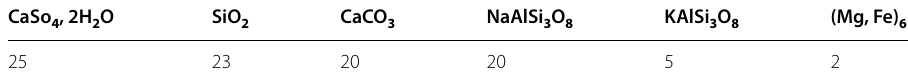
Table 2 Mineralogy of the soil sample